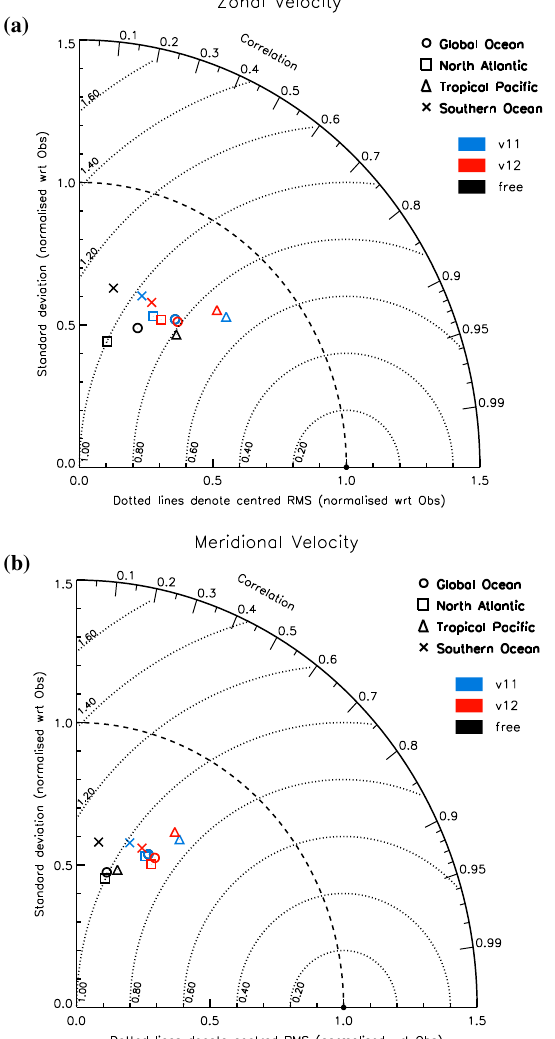
Figure 5. Taylor plots showing comparisons between model near- Fig. 5. Taylor plots showing comparisons between model near- surface currents and velocities derived from drifter locations for the surface currents and velocities derived from drifter locations for the v12 (red), v11 (blue) and free (black) trials. Results are shown for v12 (red), v11 (blue) and free (black) trials. Results are shown for the global ocean (circles), North Atlantic (squares), tropical Pacific the Global Ocean (circles), North Atlantic (squares), Tropical Pa- (triangles) and Southern Ocean (crosses) regions for (a) zonal ve- cific (triangles) and Southern Ocean (crosses) regions for (a) zonal locity and (b) meridional velocity and (b) meridional velocity.